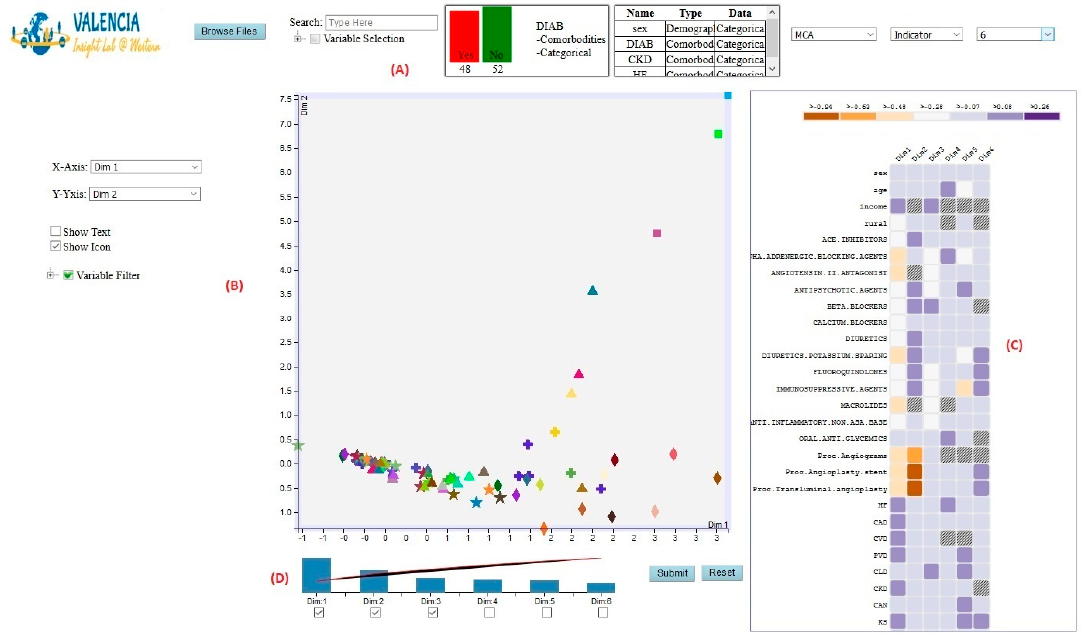
Figure 2. The dimensionality reduction (DR) view containing ( A ) raw-data subview, ( B ) projected-features subview, ( C ) association subview, and ( D ) variance subview.